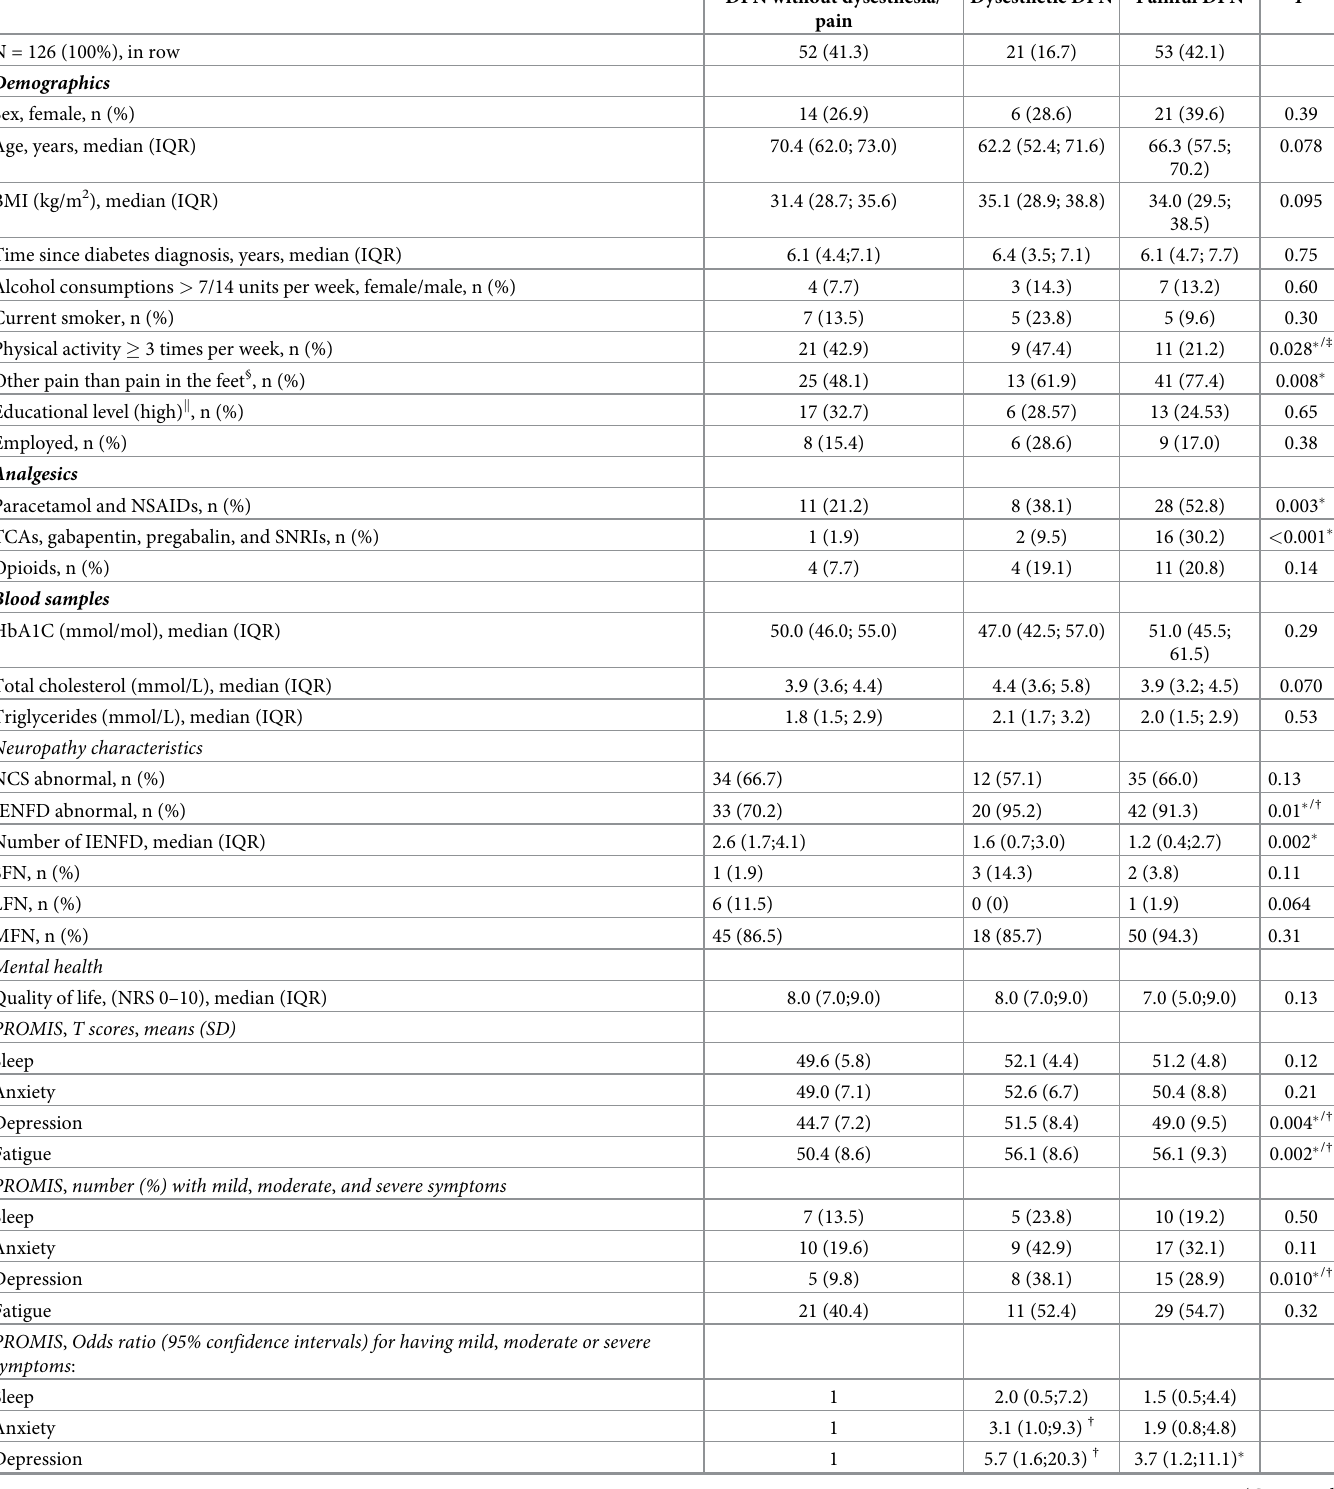
Table 1. Characteristics of patients with confirmed DPN without dysesthesia/pain, dysesthetic DPN and painful DPN.